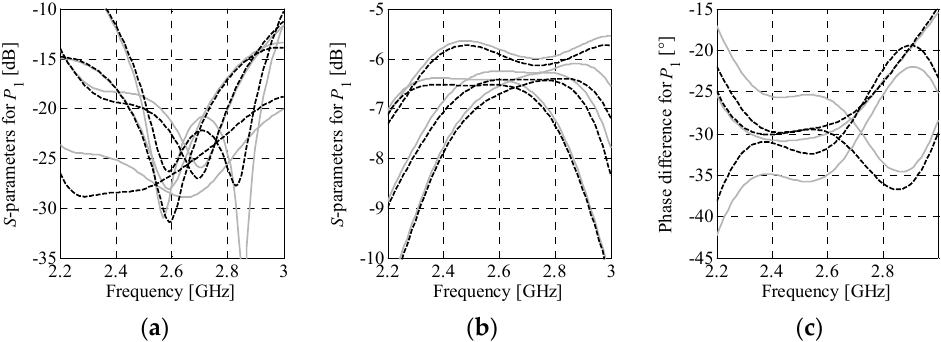
Figure 2. A conceptual illustration of the Butler matrix (BM) models: ( a ) high-fidelity EM model of the assembled matrix where (i)–(iii) denote branch line coupler (BLC), crossover, and phase-shifter, respectively, and ( b ) a composite representation of the structure. Frequency characteristics of the composite BM are obtained from the responses of individual components. In this illustration, R Bc is calculated using EM model responses of crossover (design x g.c ) and BLCs (two designs: x g .1 and x g .2 ), as well as ideal TL model of phase shifters (two designs: x e .1 and x e .2 ).